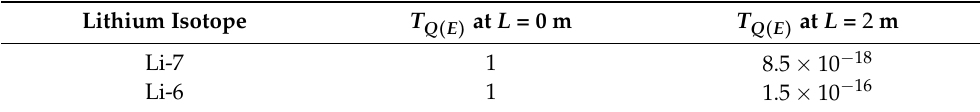
Table 2. The table shows that extracellular lithium isotopes can have a range of tunneling probability from the value at L = 0 m to the value at L = 2 m according to the setting values in graph (b) of Figure 2.